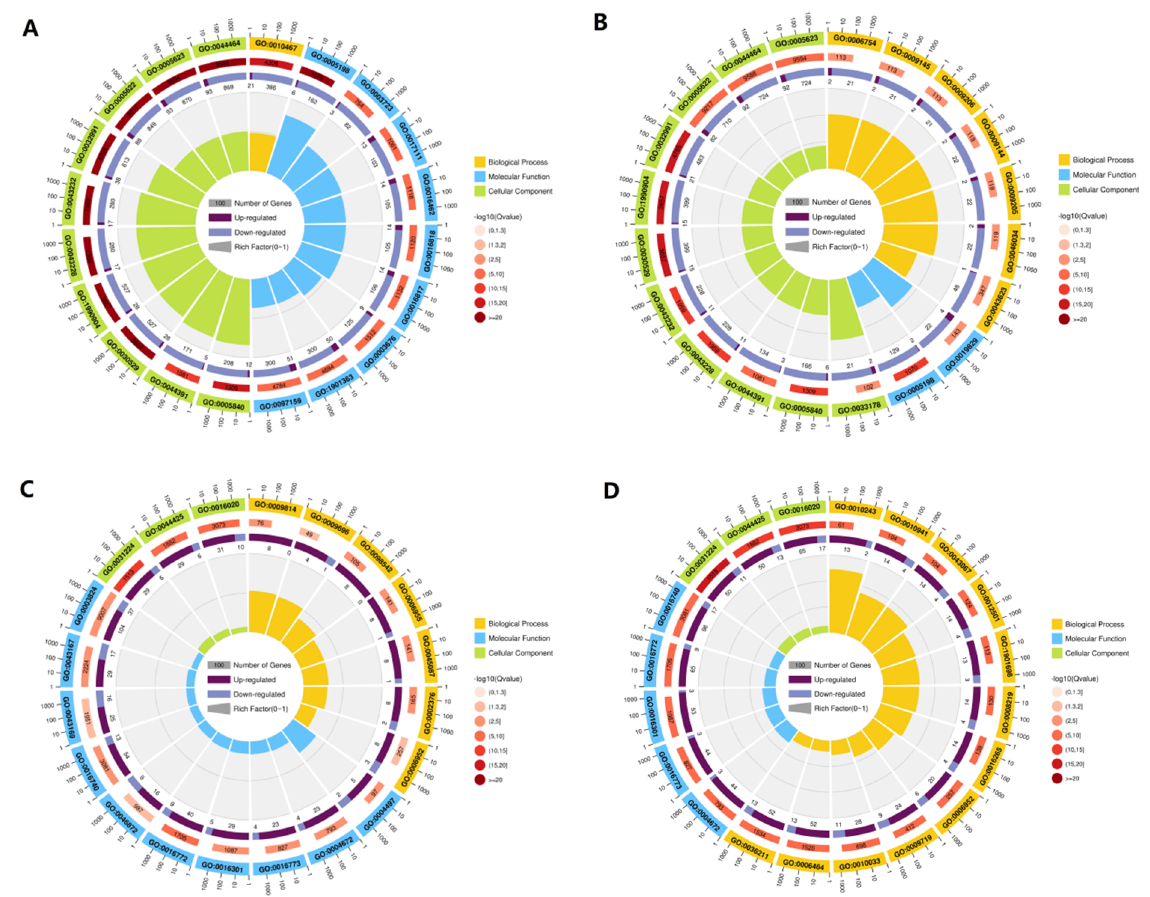
Figure 4. Gene Ontology (GO) enrichment analysis of differentially expressed genes in goldenrain tree treated with 0 mg/L, 25 mg/L, and 50 mg/L CdCl 2 for 3 days. Y = leaves; gen = roots. ( A ) genCd0 vs. genCd25; ( B ) genCd0 vs. genCd50; represent different ontologies (biological process, molecular function, and cellular component). The second circle includes the number and Q-value of the GO term in the background gene. The more genes there are, the longer the bar; the smaller the Q-value is, the deeper the red color. The third circle shows bar charts of upregulated (dark purple) and downregulated (light purple) genes, with the specific values at the bottom. The wedges in the fourth circle show the rich factor value of each GO term.